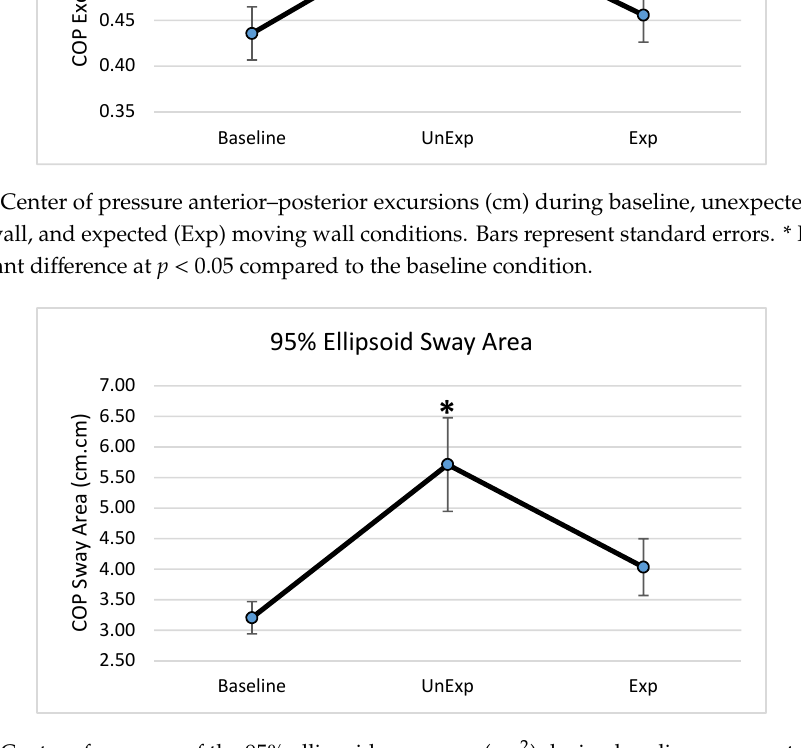
Figure 6. Center of pressure of the 95% ellipsoid sway area (cm 2 ) during baseline, unexpected (UnExp) moving wall, and expected (Exp) moving wall conditions. Bars represent standard errors. * represents a significant difference at p < 0.05 compared to the baseline condition.